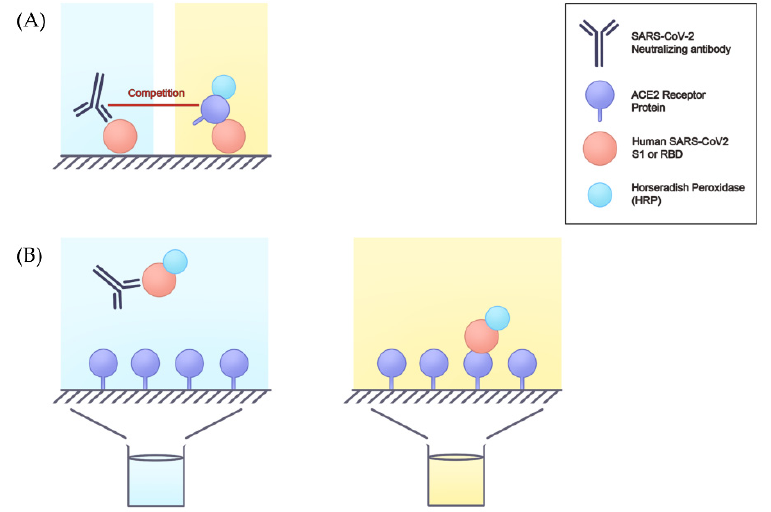
Figure 1. The principle of neutralizing antibody detection using ELISA. Based on the competitive ELISA, one of the methods ( A ), the HRP-ACE2 competes with SARS-CoV-2 neutralizing antibody to bind to the antigen-like S1 or RBD. The light signal is strong when the level of the neutralizing antibody is low. In the other method ( B ), the neutralizing antibody is pre-incubated with antigen-like S1 or RBD and then added to the well that is coated with ACE2. After the wash step, the antigens not recognized by the neutralizing antibodies can bind to the well plate (ACE2), and a bright color can also be detected. ELISA, enzyme-linked immunosorbent assay; HRP-ACE2, horseradish peroxidase-angiotensin-converting enzyme 2; RBD, receptor binding domain; SARS-CoV-2, severe acute respiratory syndrome coronavirus 2; S1, spike protein 1.